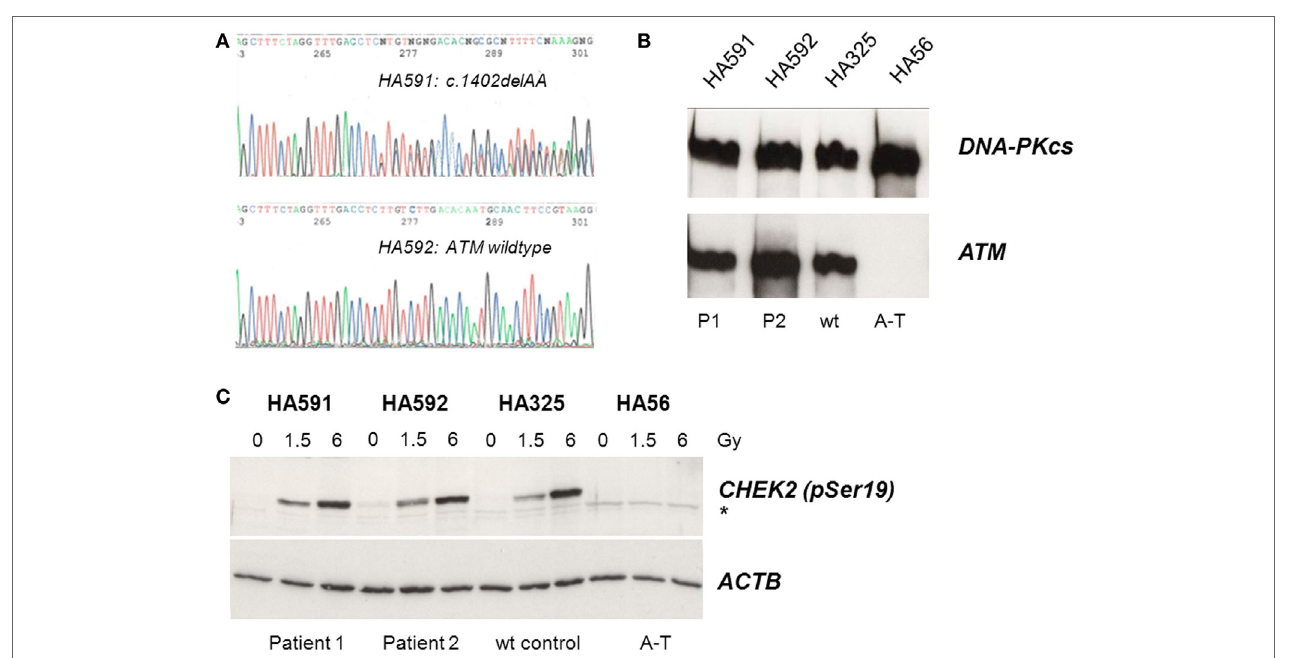
FigUre 1 | Assessment of ATM mutation (a) , ATM protein level (B) , and ATM kinase activity (c) . (a) Direct sequencing of ATM exon 12 reveals heterozygosity for the novel frameshift mutation c.1402_1403delAA in genomic DNA from the sister (HA591) but not the brother (HA592). (B) Immunoblotting detects ATM protein in lymphoblastoid cells from both patients (HA591, HA592). Lymphoblastoid cell lines (LCLs) from a healthy individual were used as an ATM-proficient control (HA325), and LCLs from a patient with classical ataxia–telangiectasia were used as an ATM-deficient control (HA56). DNA-dependent protein kinase, catalytic subunit, served as the loading control (DNA-PKcs). (c) Immunoblotting of cells after irradiation reveals radiation-induced phosphorylation of the ATM substrate KAP1 at Ser824. Cells were irradiated with 0, 1.5, or 6 Gy, respectively, and proteins were extracted at 30 min after irradiation. LCLs from a healthy individual were used as an ATM-proficient control (HA325), and LCLs from a patient with classical ataxia–telangiectasia were used as an ATM-deficient control (HA56). β -actin served as the loading control